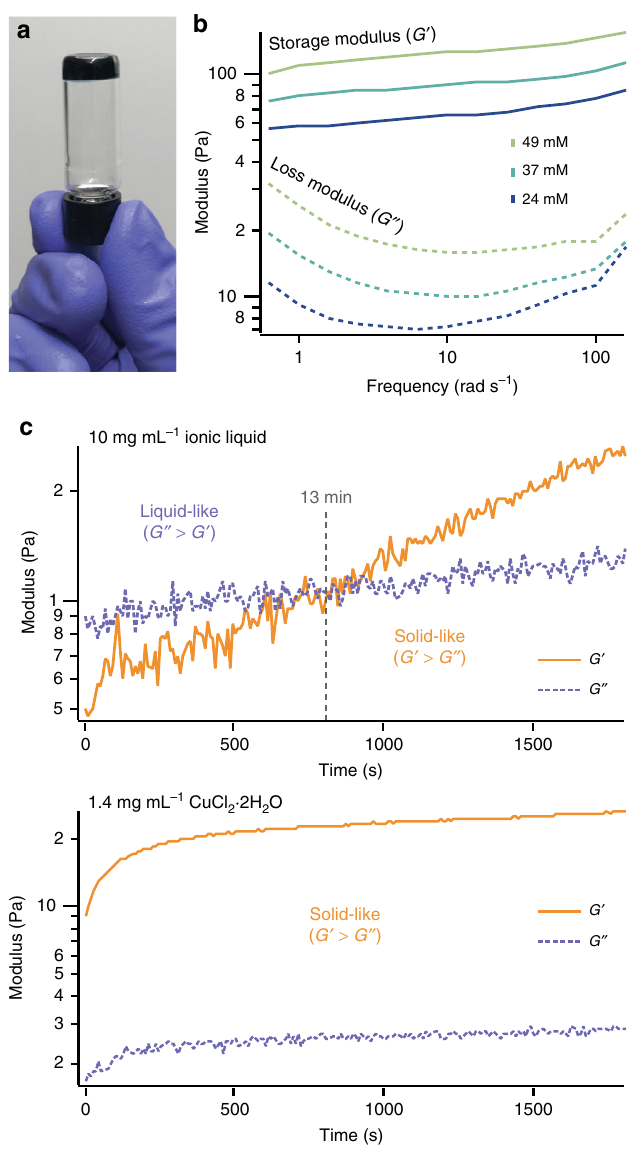
Fig. 2 Gelation of PEDOT:PSS. a , b PEDOT:PSS forms a gel a after mixing it with ionic liquid. The gel strength, given by storage modulus ( G ’ ), increases with increasing ionic strength b . c Mixing PEDOT:PSS with either ionic liquid or CuCl 2 will cause the solution to gel, although the gelation occurs much more rapidly with CuCl 2 . With ionic liquid, the PEDOT:PSS mixture only starts to become more solid-like ( G ’ > G ” ) after 13 min. By contrast, the mixture with CuCl 2 gels so quickly that G ’ already exceeds G ” by the start